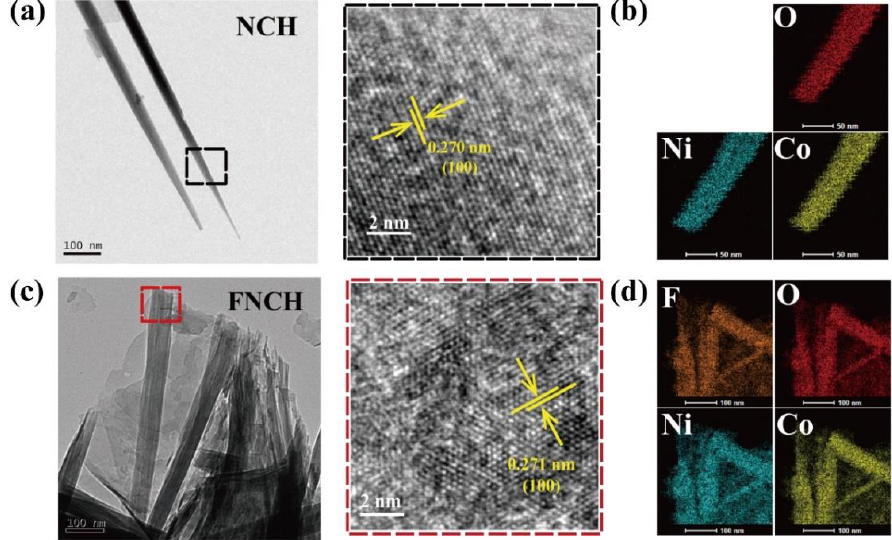
Figure 2. TEM images of NCH ( a ) and FNCH ( c ); TEM EDX mapping of NCH ( b ) and FNCH ( d ).